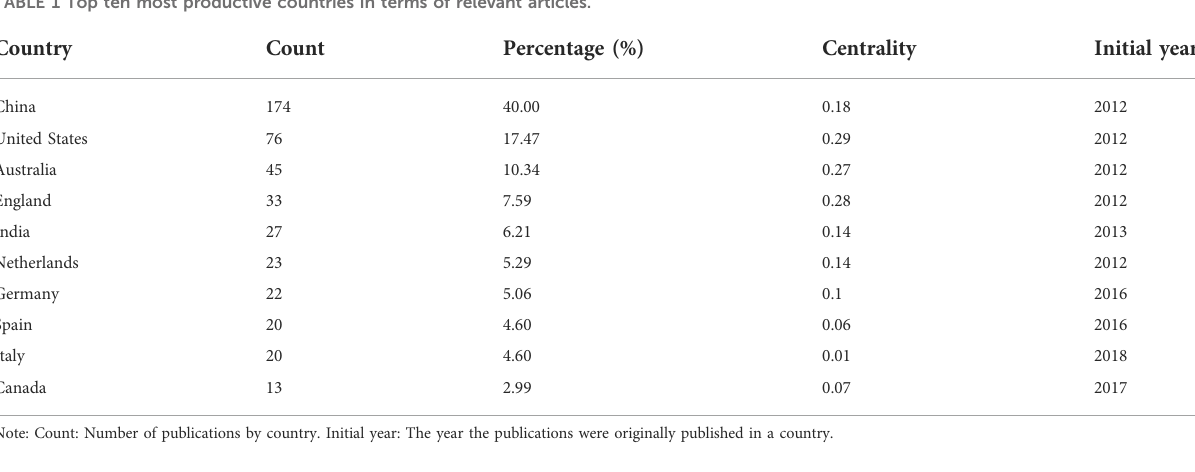
(Table 3), the publication volume, TC a value, and h-index value